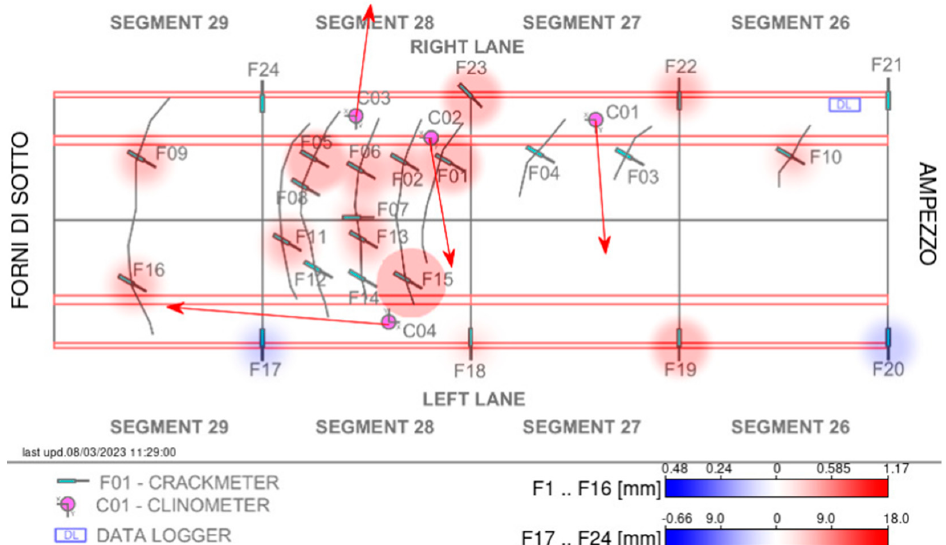
Figure 1. A screenshot of WBP, developed by the authors for the Italian National Road Authority (A.N.A.S.). It concerns the structural health monitoring system for a tunnel damaged by a landslide [25]. Ampezzo and Forni di Sotto are two municipalities in northeast Italy. The figure shows positive displacements in red and negative displacements in blue, recorded in crackmeters. The arrows show the vector components from another type of sensor, clinometers. In a single image, all the instruments installed in this tunnel segment are shown together to provide a full impression of the status of the structure.